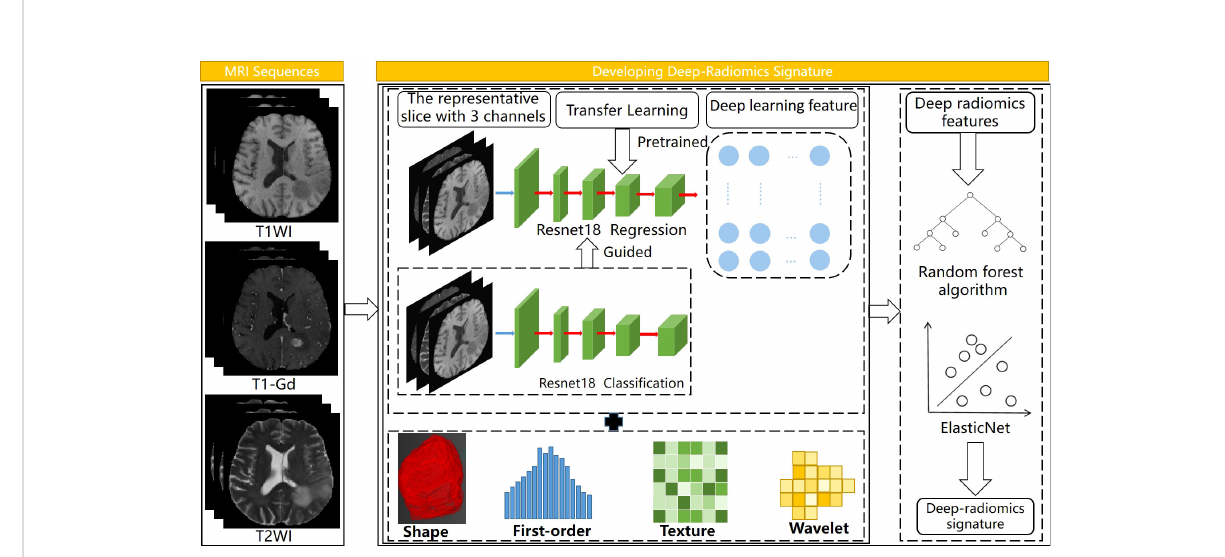
FIGURE 2 Work fl ow of developing deep-radiomics signature, the regression network was guided by the classi fi cation network. Elastic Net was used to develop the deep radiomics